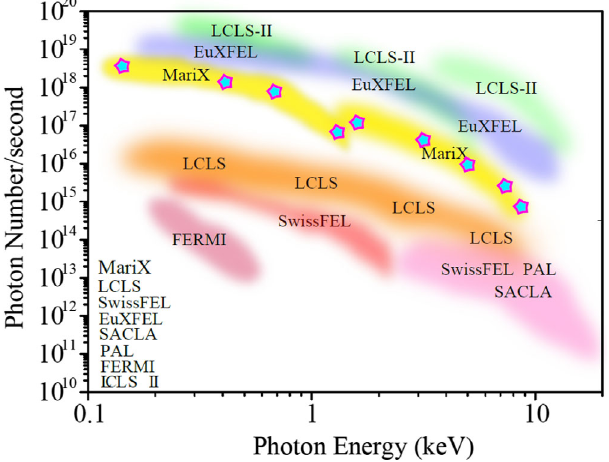
FIG. 15. Expected performance of MariX free electron laser (yellow area), in terms of photon flux as a function of the photon energy in the 0.2 – 8 keV anticipated dynamic range, showing performance above present FELs driven by normal conducting linacs, second only to the anticipated performance of LCLS-II and